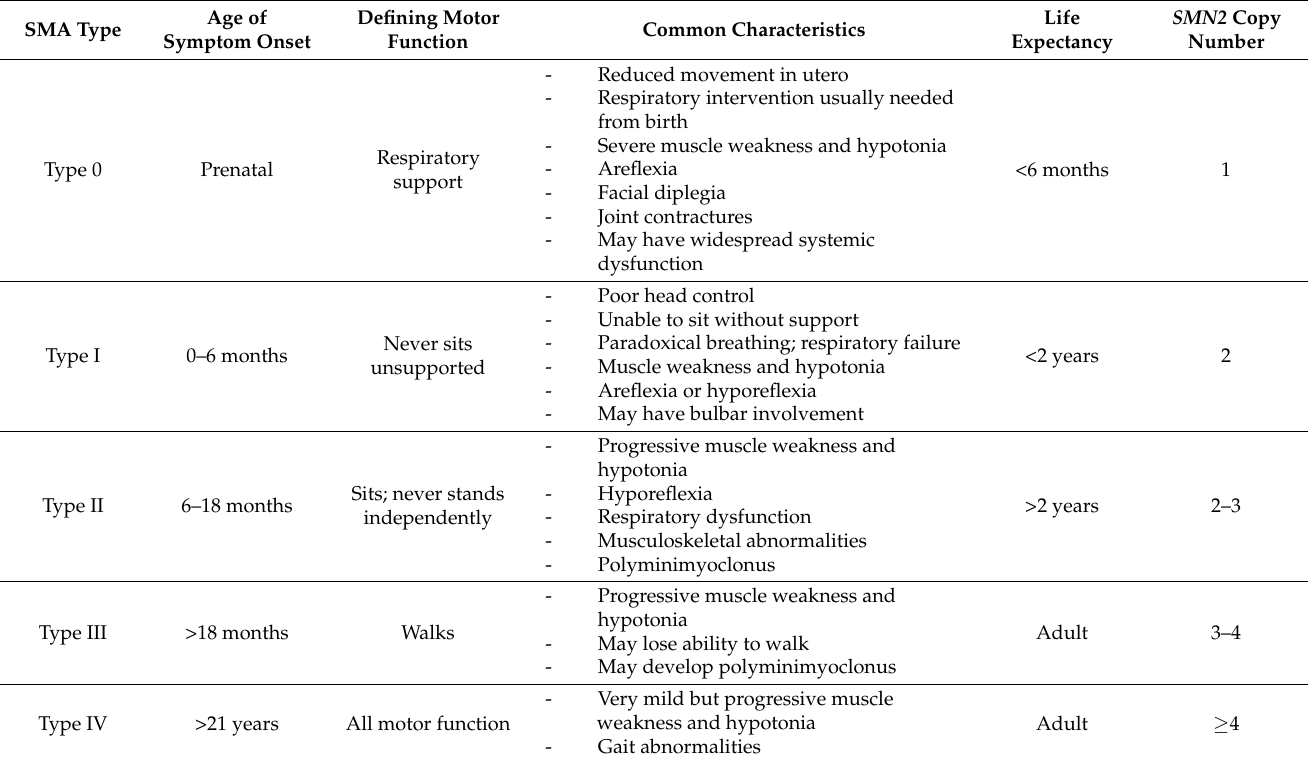
Table 1. Natural histories of Type 0–Type IV